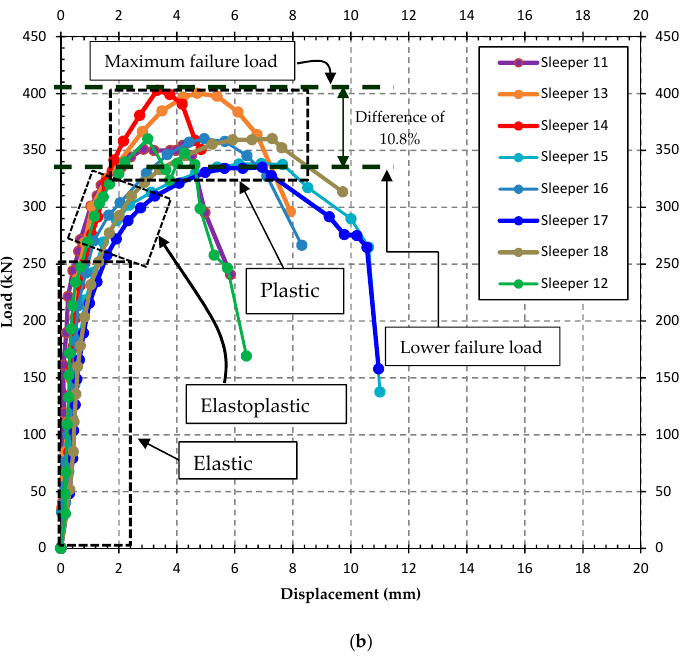
Figure 8. Experimental results: ( a ) positive moment test at midspan; ( b ) positive moment test at the support.